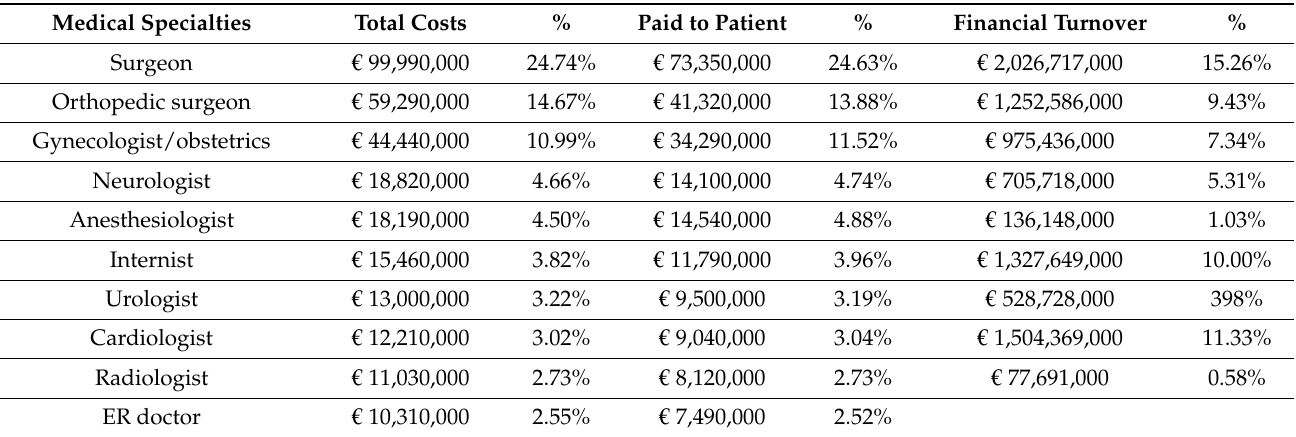
Table 2. Top 10 medical specialties with the highest costs (total claim costs in 15 years) related to their share in financial turnover of all medical specialties (the share per medical specialty based on